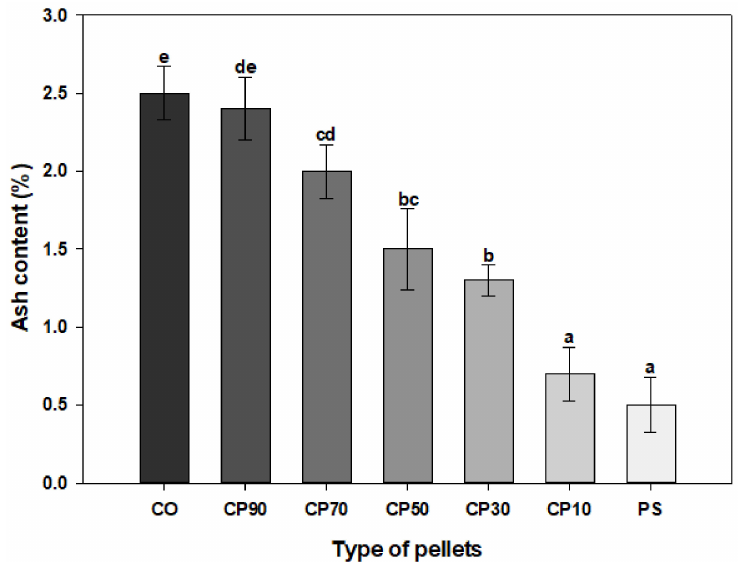
Figure 8. Ash content of pellets according to SCG blending ratio. Each point is the mean of three repeated measurements and is the mean ± standard deviation. The means with different letters (a–e) above the bars indicate significant differences based on Tukey’s HSD test ( p <